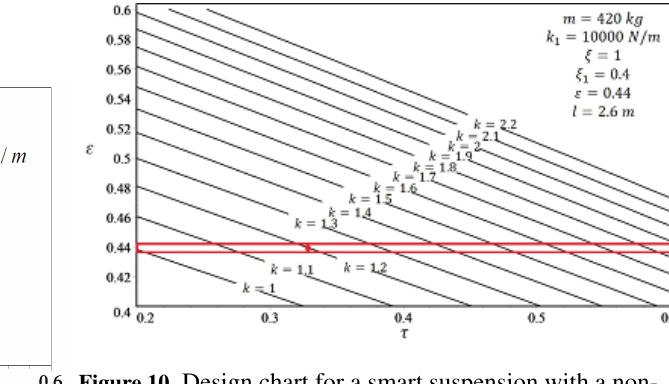
Figure 10. Design chart for a smart suspension with a non- linear